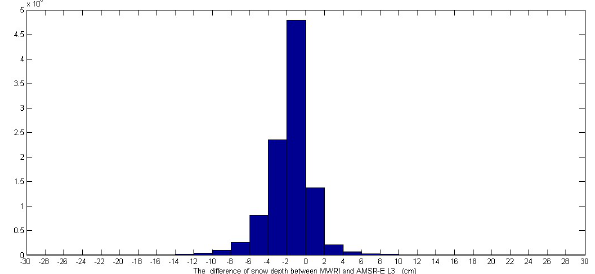
Figure 7. The histogram of the snow depth differences in January 2011